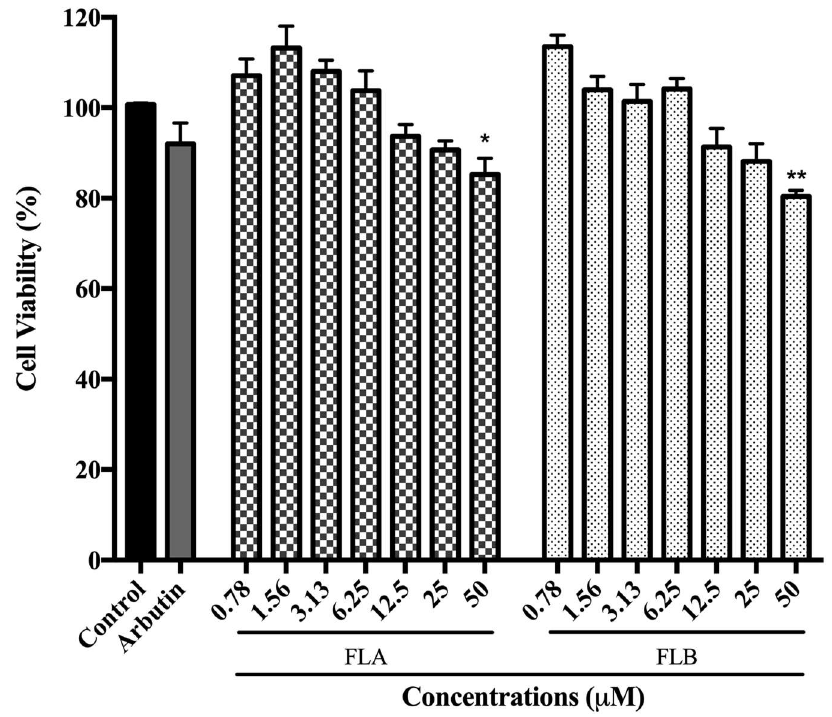
Figure 1. Cell viability of α-MSH induced B16/F10 cells after 72 h treatment with FLA and FLB. Toxicity effects of FLA and FLB were determined with respect to induced control by MTT assay. FLA and FLB were tested for cytotoxic effect at different concentrations of 0.78–50 µM. Arbutin (50